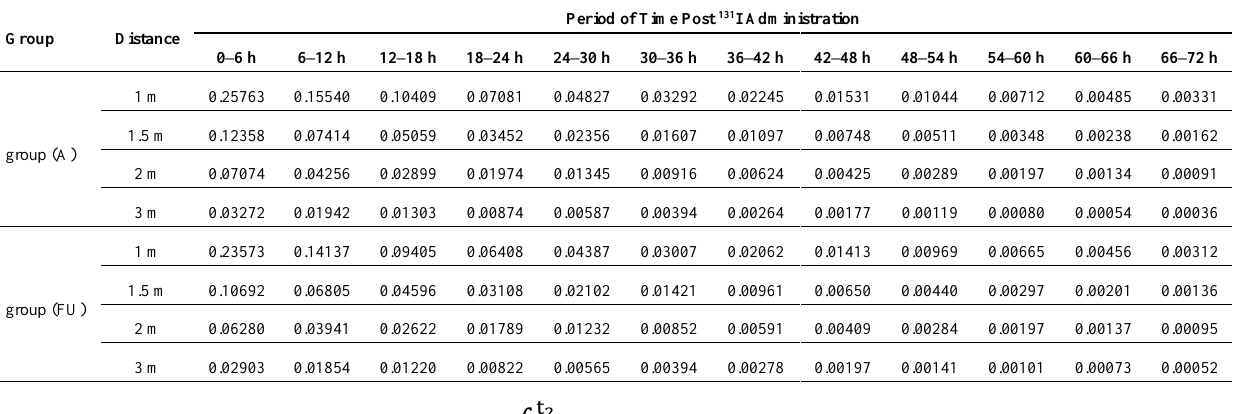
Table 2. Normalized cumulative dose around patients in each period of time post 131 I administration (μSv·MBq −1